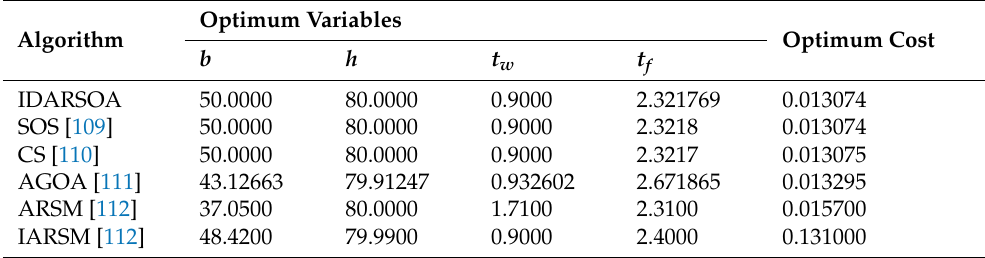
Table 13. Comparison results of I-beam